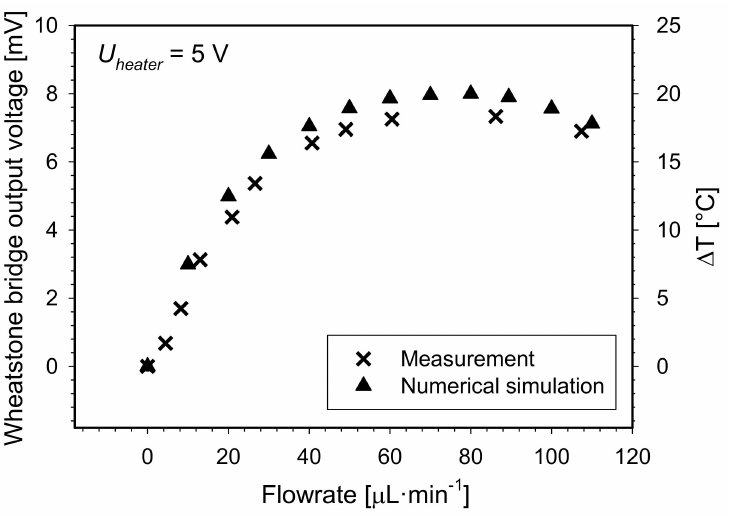
Figure 13. Measured and simulated Wheatstone bridge output signal and differential tempera- ture between both sensor elements vs. flowrate for S-H-S configuration with a constant heater supply